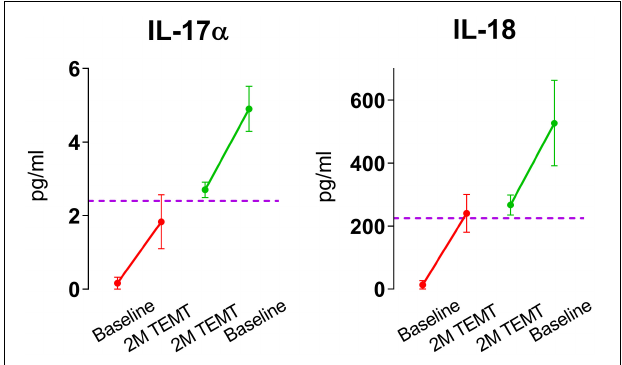
FIGURE 4 | Means and SEMs for the individual subjects shown in Figure 3 for IL-17 α and IL-18. As is evident for both cytokines, the response to TEMT is dependent on baseline levels, with TEMT inducing convergence (rebalancing) of both IL-17 α and IL-18 toward aged normal levels (horizontal dashed line).